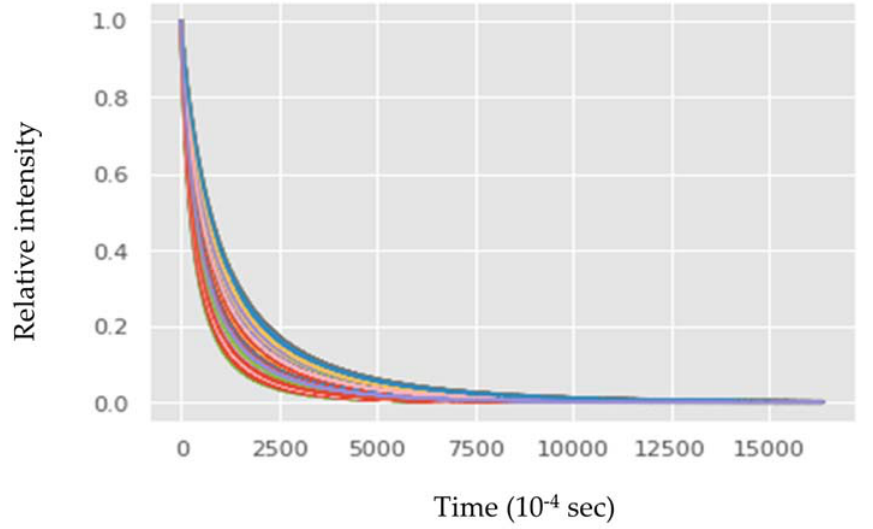
Figure 6. Low-field nuclear magnetic resonance (NMR) T 2 relaxation time of thermally induced linseed oil sample oxidation. Each line color represents from top to bottom T 2 relaxation time (0 h, 12 h, 24 h, 48 h, 96 h, and 120 h).